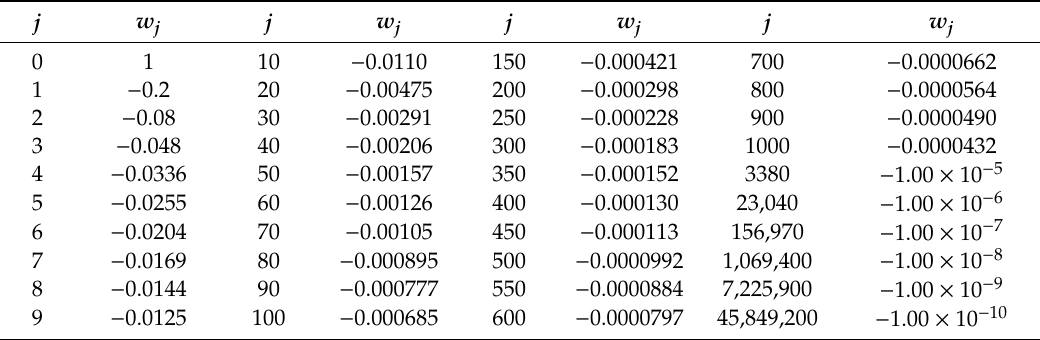
Table 2. Partial binomial coe ffi cients for α =